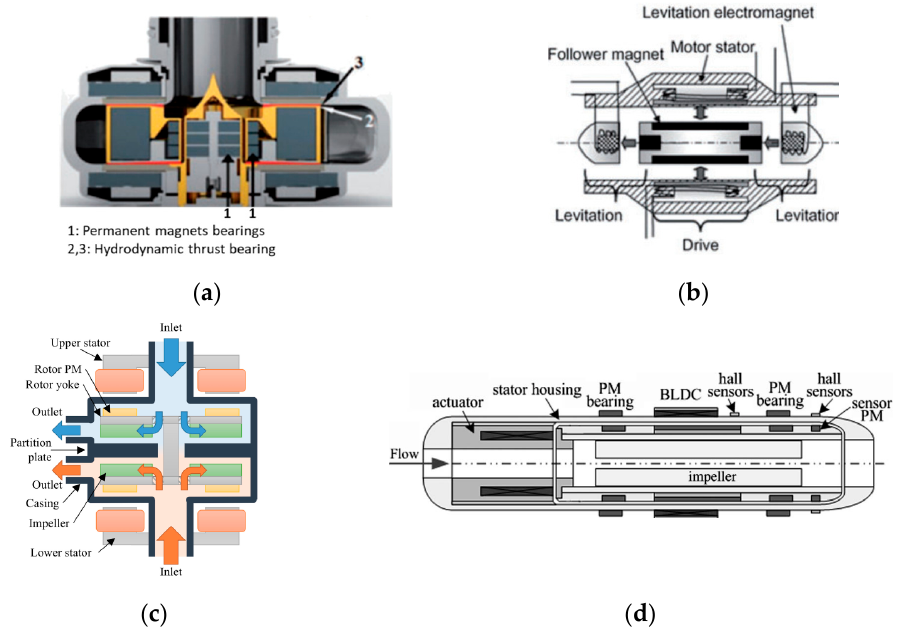
Figure 4. Magnetic bearings for blood pumps; ( a ) PM assisted by hydrodynamic thrust bearing; ( b ) electromagnetic bearings; ( c ) bearingless axial flux motor for CFPs; and ( d ) bearingless BLDC motor for CFPs. Republished with permission of IEEE.